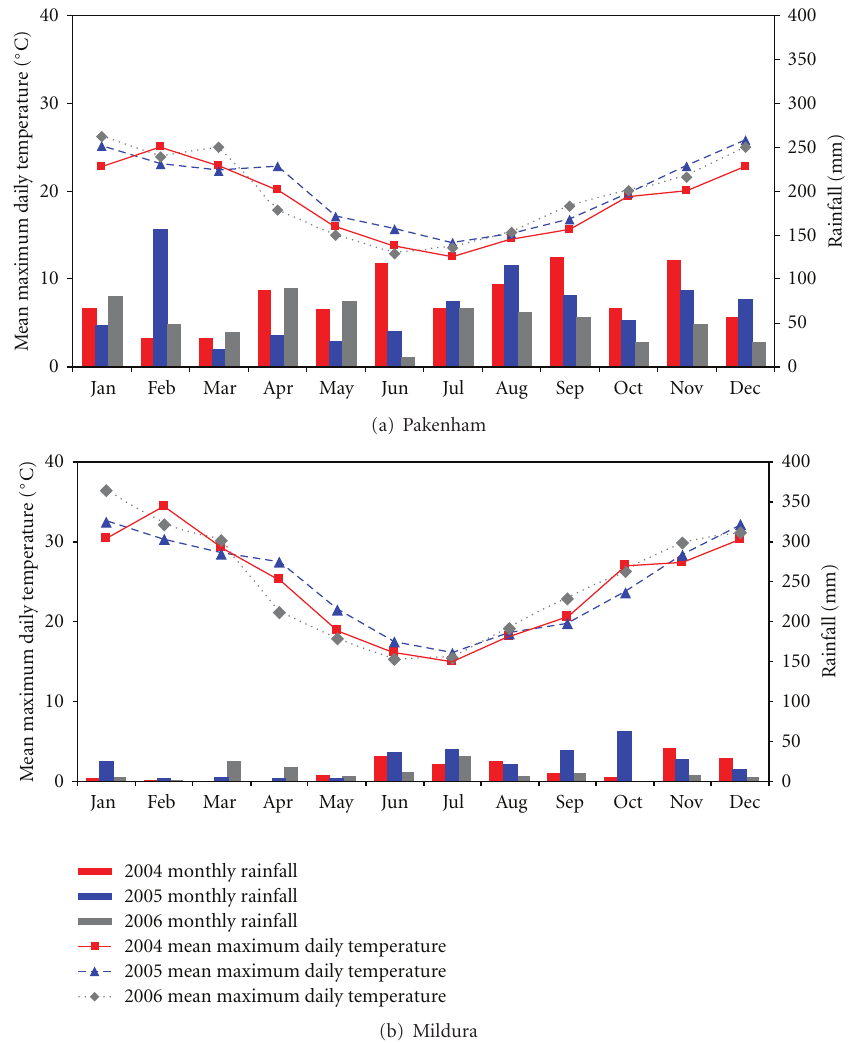
Figure 1: Mean monthly rainfall and mean daily maximum temperature for the Pakenham (a) and Mildura (b) sites used for the National Biosolids Research Program,